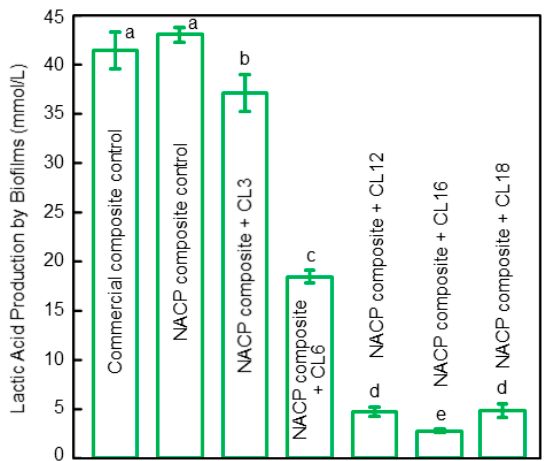
Figure 2. Lactic acid production by two-day dental plaque microcosm biofilms on the composites vs. QAM amine alkyl chain length (CL) (mean ± SD; n = 6). The polymeric composite using CL16 had the strongest anti-biofilm activity. Values indicated by dissimilar letters are statistically significantly different from each other ( p < 0.05). Adapted from [36], with permission from © 2015 Springer Nature.